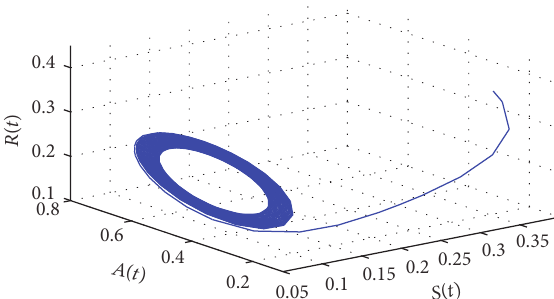
Figure 1: The phase plot of states 𝑆 ∗ , 𝐴 ∗ , and 𝑅 ∗ with 𝜏 1 = 22.36 < 28.4522 = 𝜏 10 .